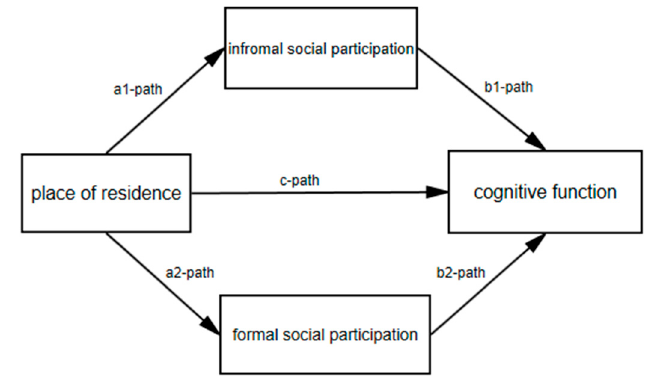
Figure 1. Overview of the analysis framework.